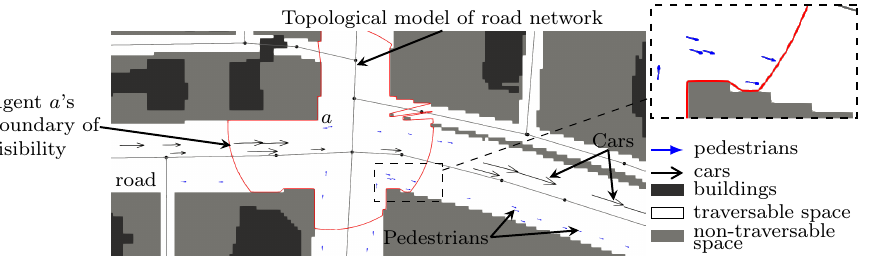
Figure 1. An example of the grid and graph environment with a snapshot of agents’ movements at a junction. Blue and black arrows indicate instantaneous velocities of pedestrians and cars,